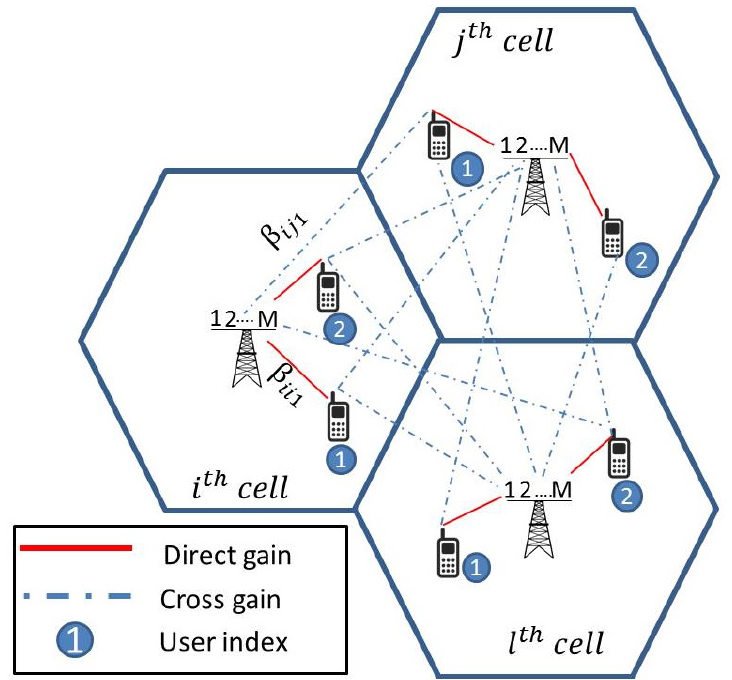
Figure 1. A three multi-cell massive MIMO